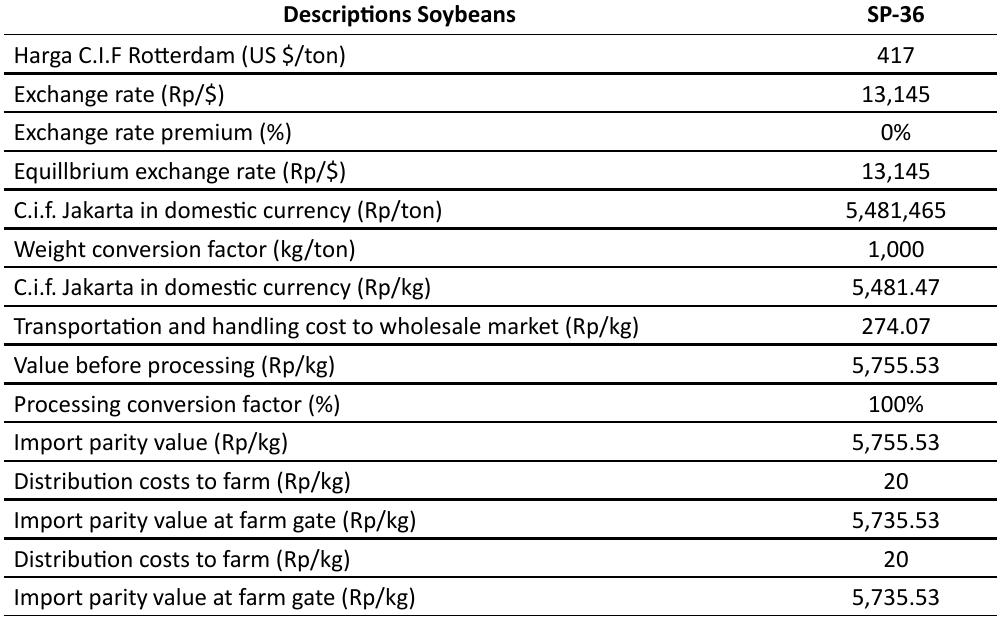
Table 6: Import Parity Price for Soybeans Descriptions